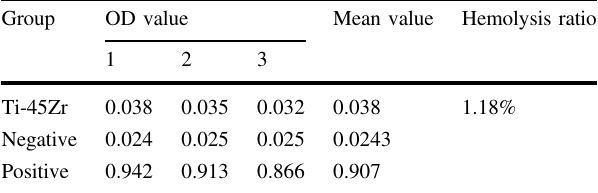
Table 1 Hemolysis rate of the Ti-45Zr alloy Group OD